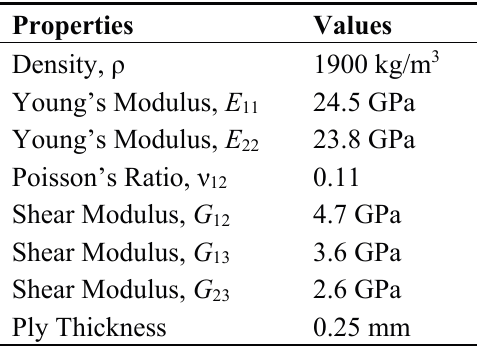
Figure 4. The uniaxial stress-strain curves of neoprene rubber [13] and silicone. Table 3. Material properties of glass-fiber prepreg EHG250-68-37 composite